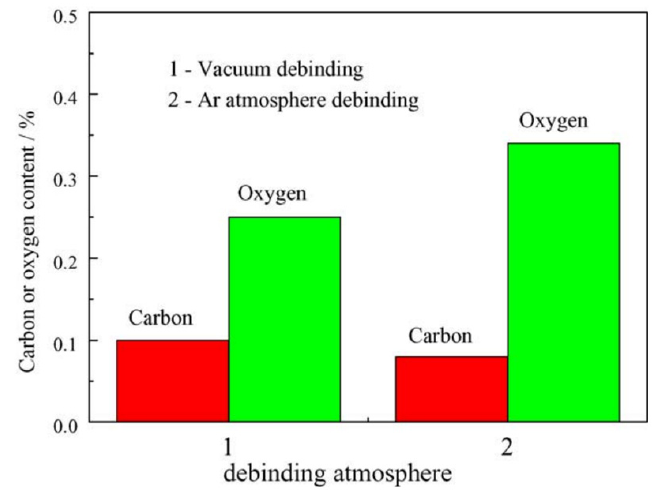
Figure 11. Effect of debinding atmosphere on the C and O uptake during debinding of Ti-6Al-4V MIM (Reprinted with permission from [179]. Copyright 2006, Journal of Materials Processing Technology,